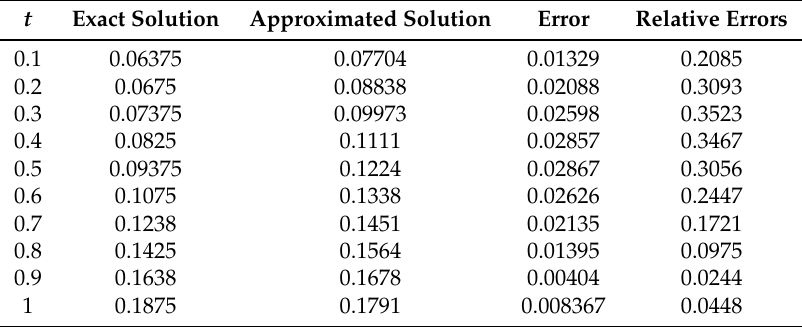
Table 1. Comparing approximated and first component of exact Solution with error.